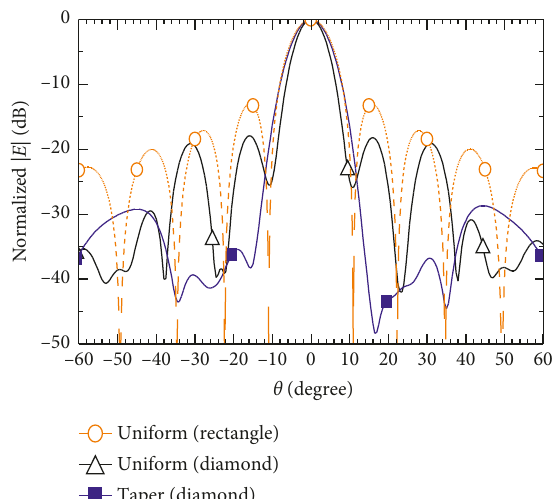
Figure 5: Simulated xz -plane normalized patterns of the subarray at 38GHz for the rectangular aperture in Figure 2, the diamond-shaped aperture with uniform radiation power, and the diamond-shaped aperture with tapered radiation power.